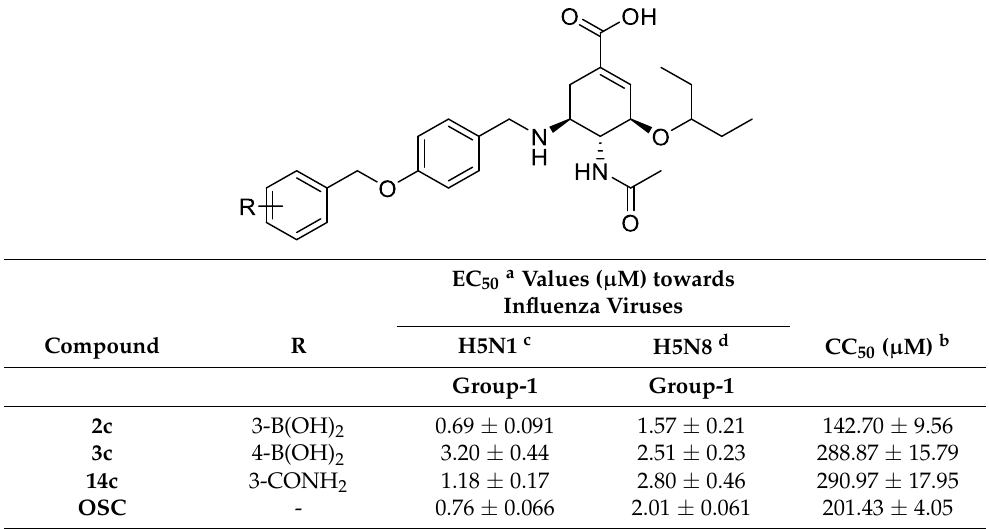
Table 2. Anti-influenza virus activity and cytotoxicity of oseltamivir derivatives in CEF cells.